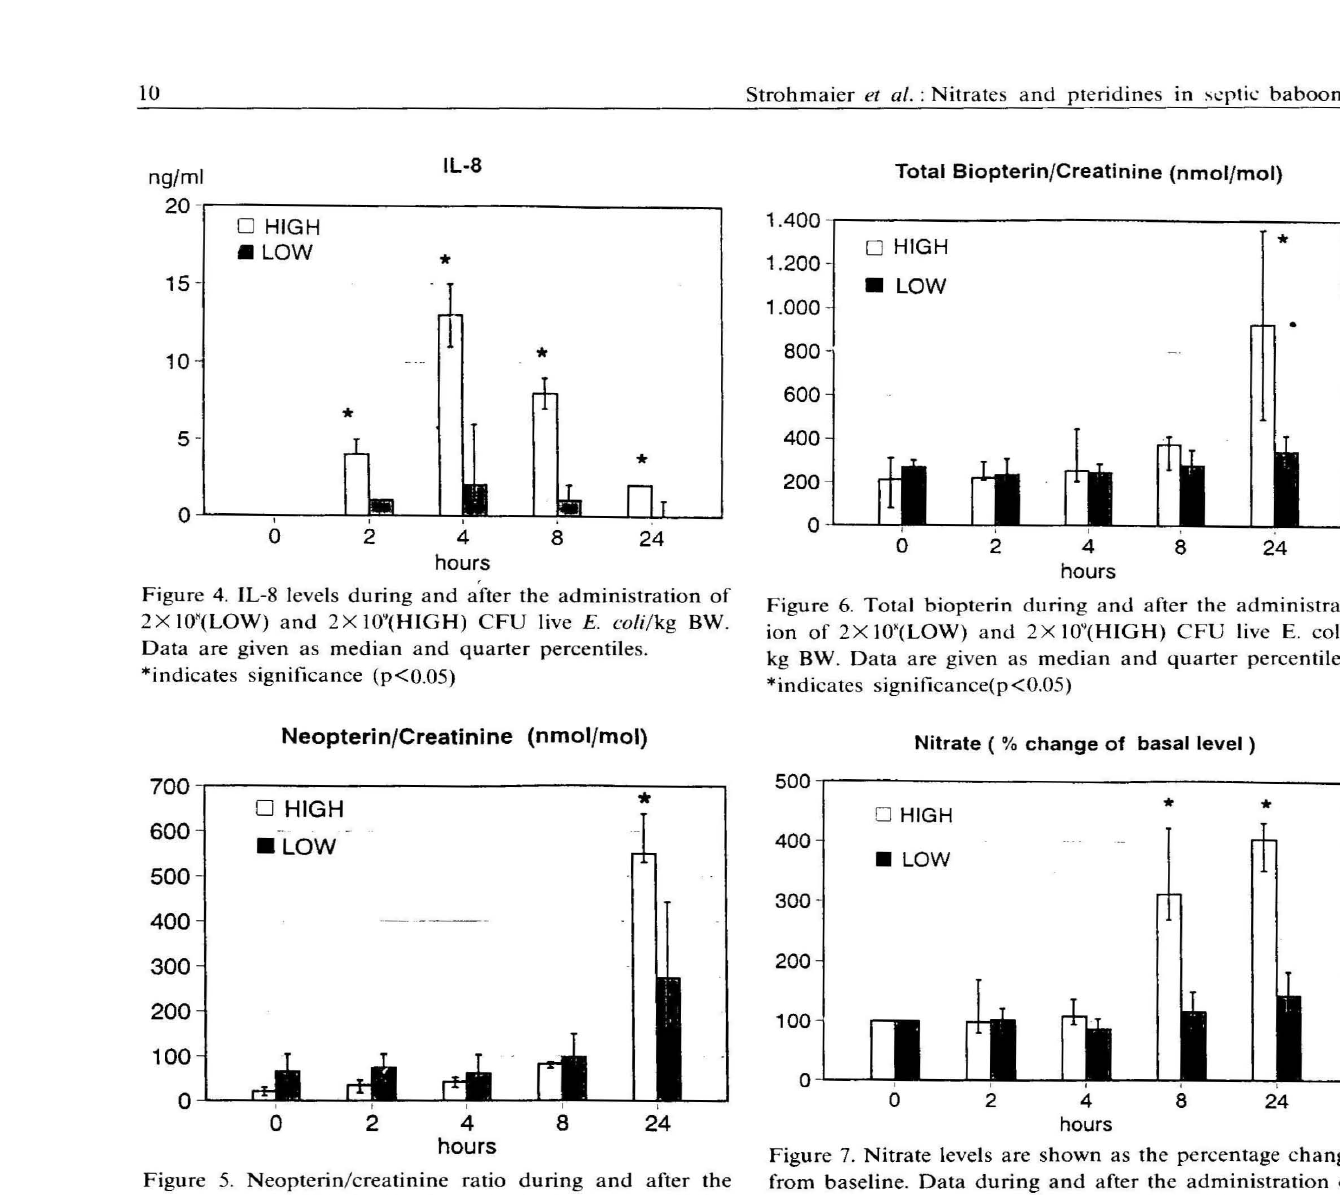
Figure S. Neopterin/creatinine ratio during and after the administration of 2X IO'(LOW) and 2X 10 9 (HIGH) CFU live E. coli/kg BW. Data are given as median and quarter pe rcentiles.